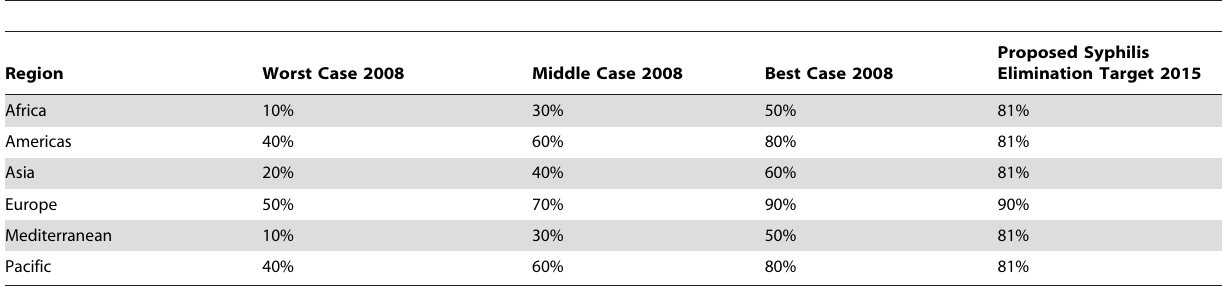
Table 1. Estimated proportion of antenatal care attendees tested and treated in different scenarios for 2008, and proposed Initiative for the Global Elimination of Congenital Syphilis target for